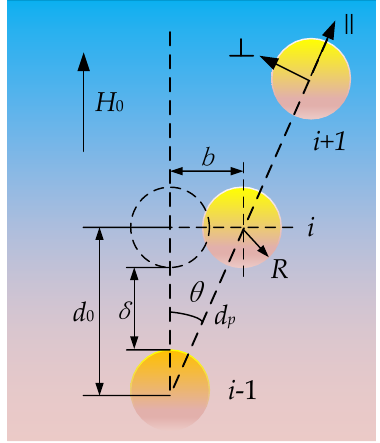
Figure 5. Particles in a magnetic chain. The shear yield stress of the MRF can be mainly divided into two parts: the magneti- cally induced yield stress of the modified dipole model, τ m , and the friction yield stress by tribology, τ f . The additional shear stress approximation caused by the applied magnetic field can be obtained from [19]: